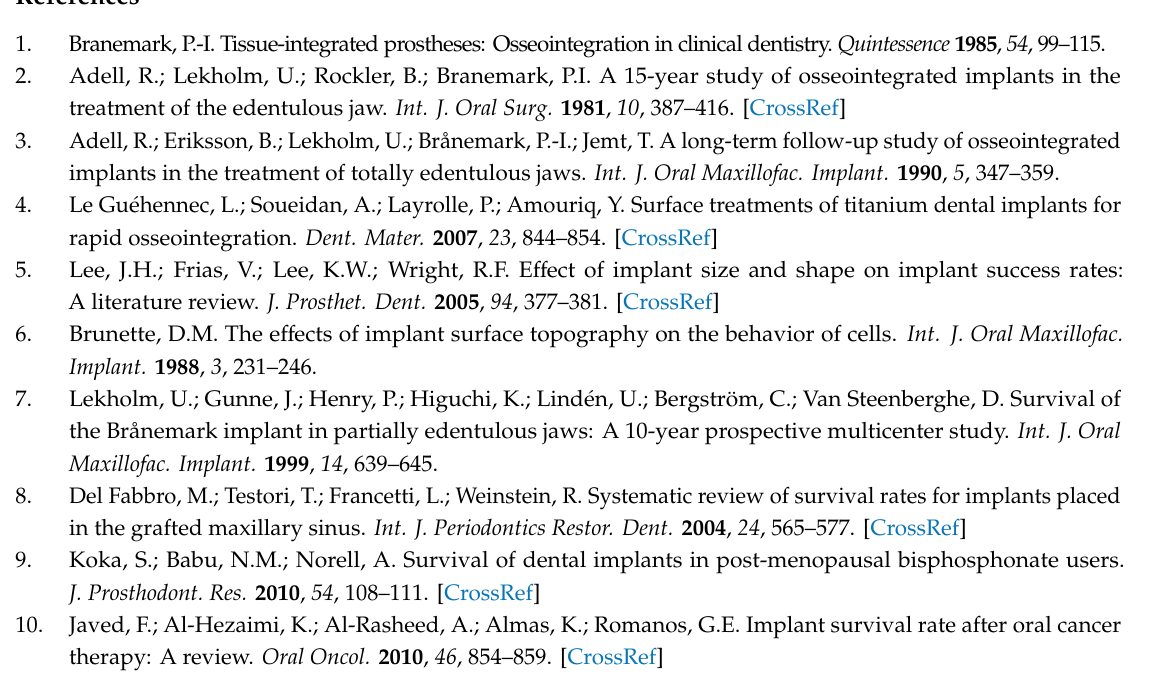
Table S1: Test and validation accuracy according to multiple validation